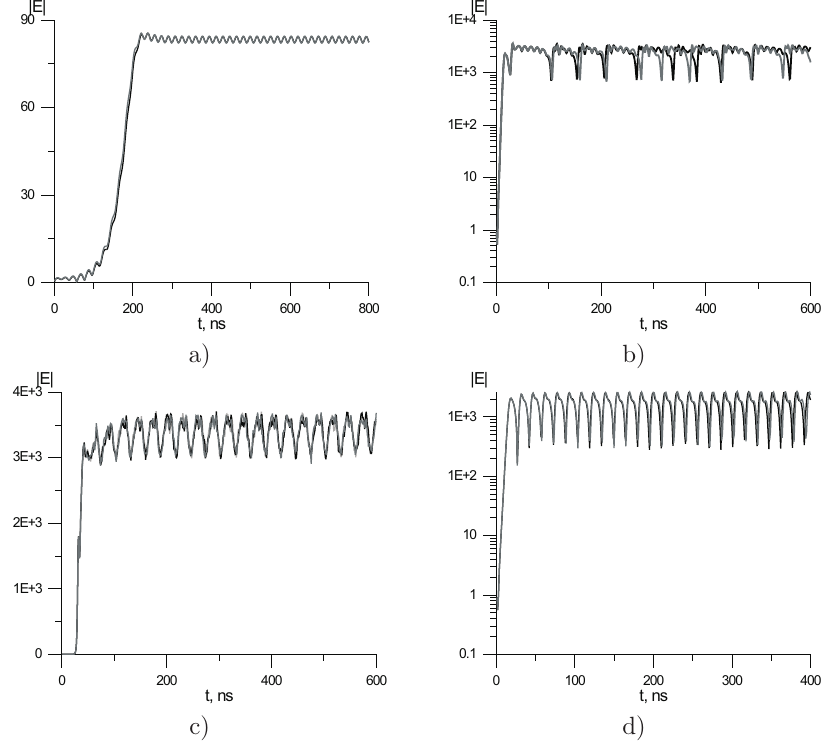
Figure 3. Sensibility to initial conditions for different VFEL regimes: (a) periodic, (b) and (c) chaotic, (d) quasiperiodic. In each plot there are two curves (black and grey) corresponding to the following sets of parameters: (a) j = 500 A/cm 2 , | E 0 | = 1 and | E 0 | = 1 . 1 ; (b) j = 2300 A/cm 2 , | E 0 | = 1 and | E 0 | = 1 + 10 − 15 , (c) j = 2000 A/cm 2 and j = 2000+10 − 8 A/cm 2 , (d) j = 1950 A/cm 2 and j = 1960 A/cm 2 . It is